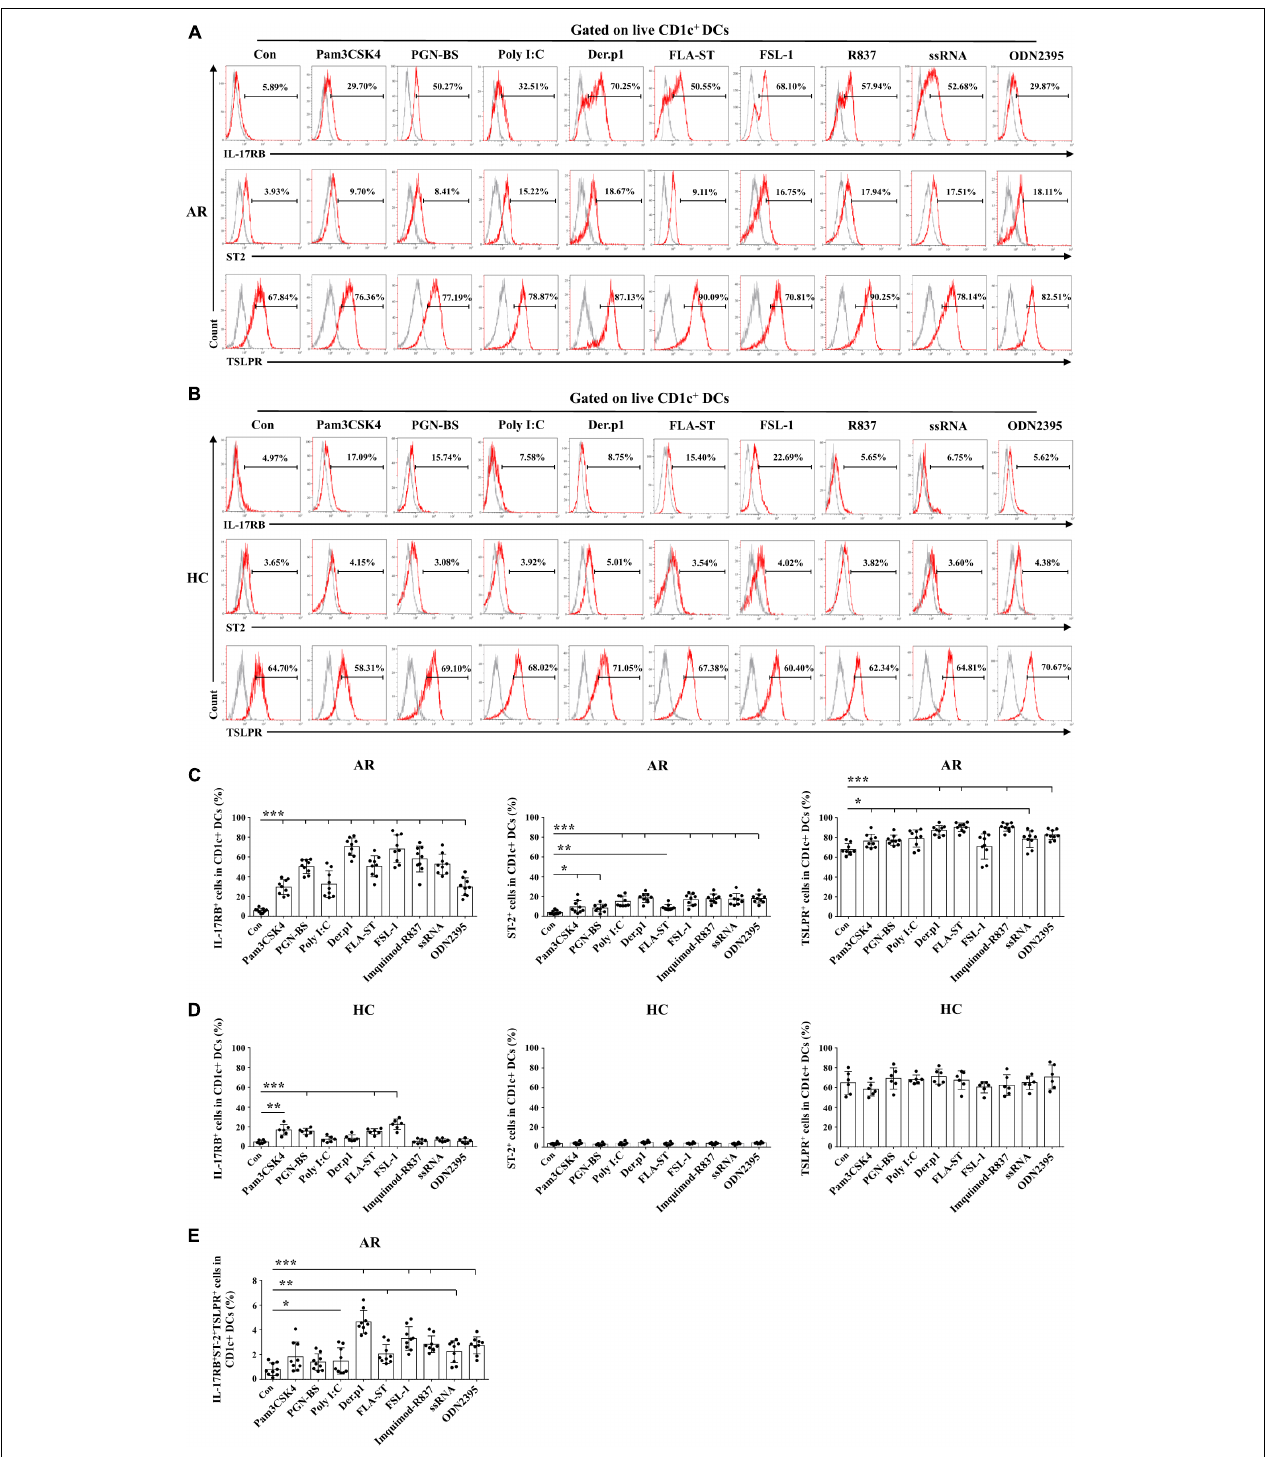
FIGURE 1 | TLR ligands induced allergic rhinitis (AR)-derived monocyte-derived DCs (mo-DCs) to express IL-17RB, ST2, and thymic stromal lymphopoietin (TSLPR). (A,B) Representative flow plots of IL-17RB, ST2, and TSLPR expression on CD1c + mo-DCs derived from AR ( n = 9) and healthy control (HC) ( n = 6) subjects before and 48 h after stimulation with Pam3CSK4, PGN-BS, Poly I:C, Der.p1, FLA-ST, FSL-1, Imiquimod-R837, ssRNA, and ODN2395. Gray histograms were negative isotypes. (C,D) Quantification of percentages of IL-17RB + , ST2 + , and TSLPR + cells in CD1c + mo-DCs derived from AR and HC subjects. (E) Quantification of percentages of IL-17RB + ST2 + TSLPR + cells in CD1c + mo-DCs derived from AR subjects. Data are expressed as means ± standard deviation (SD). Significant differences were tested using the paired t -test between control and TLR groups, and using Student’s t -test between TLR stimulation groups. * P < 0.05, ** P < 0.01, *** P <